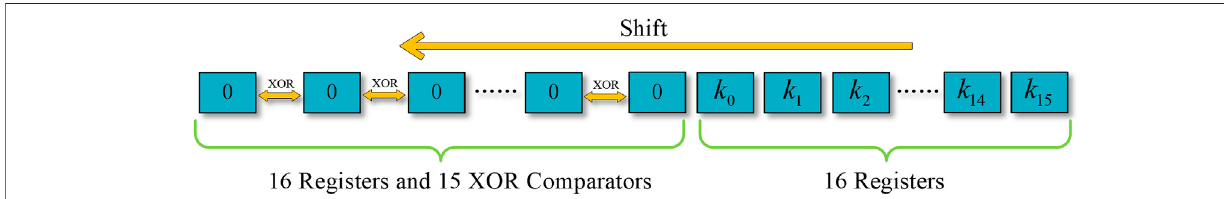
FIGURE 9 | Flow chart of the initial state of the post-processing unit.